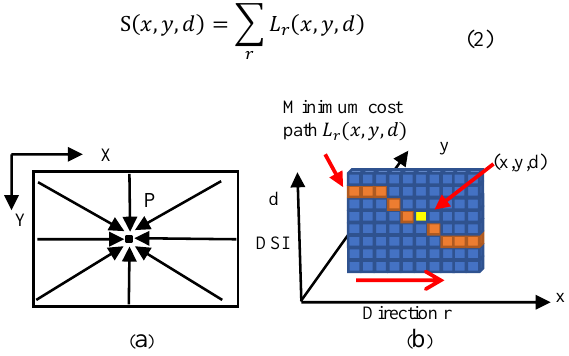
Figure 2. (a) Semi-global optimization, and (b) Minimum cost path